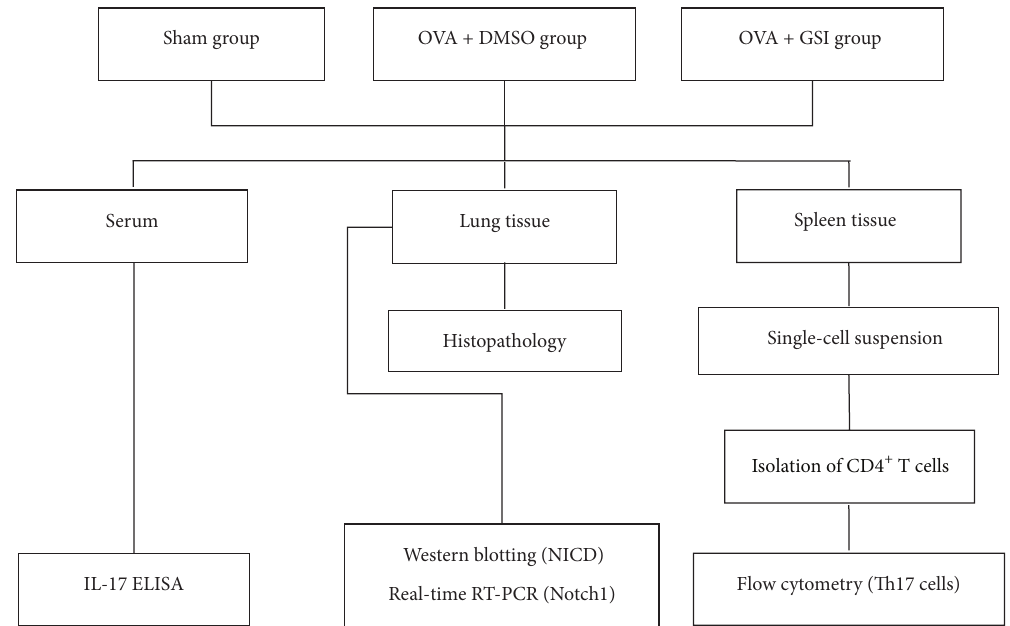
Figure 1: Flowchart of experimental